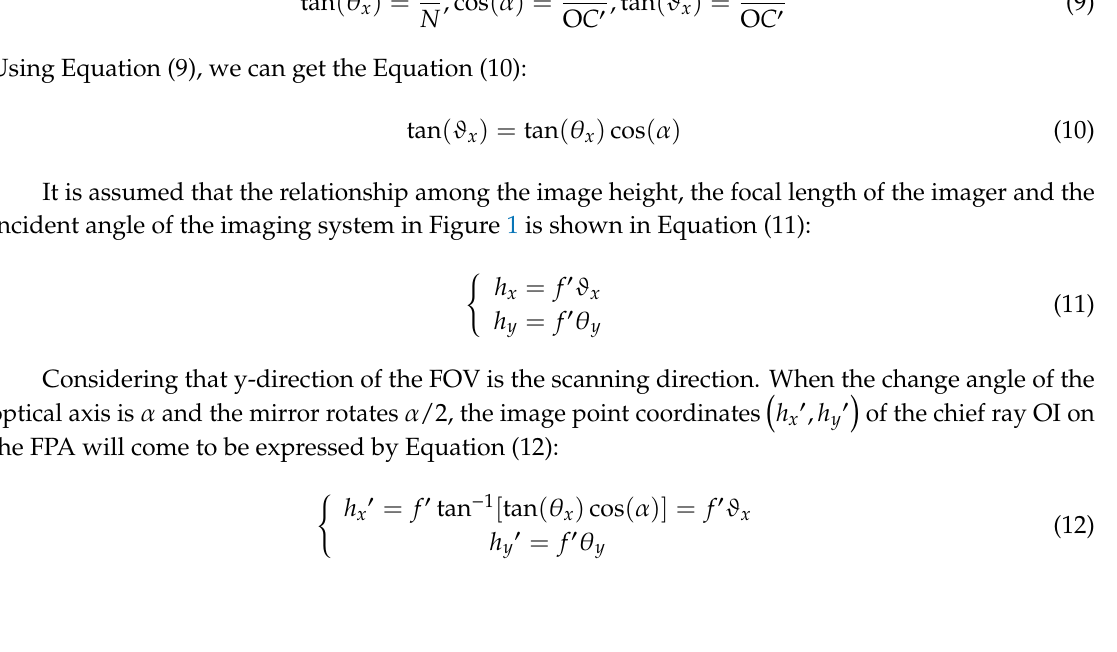
Figure 3. A schematic diagram of the new projection relationship. Oz is the original optical axis. When the optical axis is in the state B, θ y = α , the new optical axis changes to Oz (cid:48) . The projection point of OI y on the original optical axis Oz is C . The intersection of I y C and the new optical axis is C (cid:48) . I x (cid:48) C (cid:48) is parallel to I x C . The angle between OI x (cid:48) and the new optical axis is ϑ x , which can be defined the field angle in the x direction.